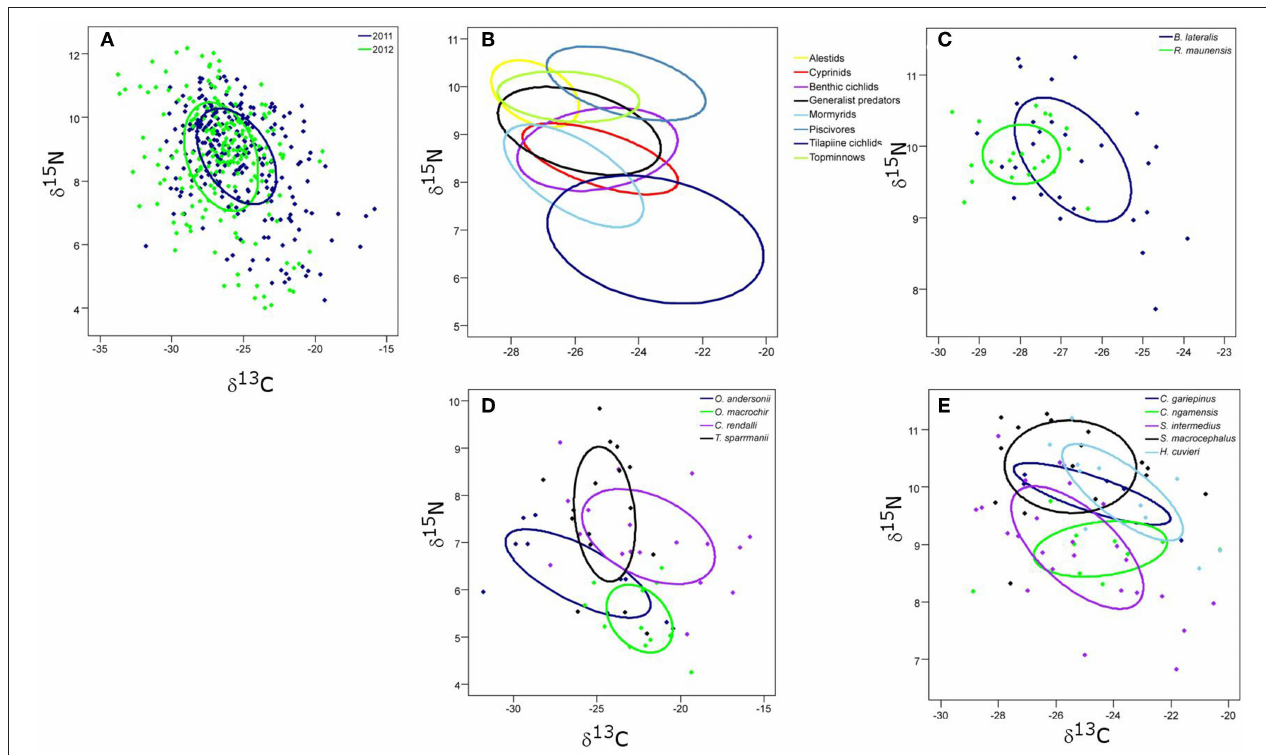
FIGURE 5 | The core isotopic niche areas (SEAc) of (A) 2011 and 2012 complete fish communities; (B) all fish groups; (C) alestid species; (D) the four tilapiine cichlid species; and (E) the predatory fish species in Lake Liambezi in 2011.